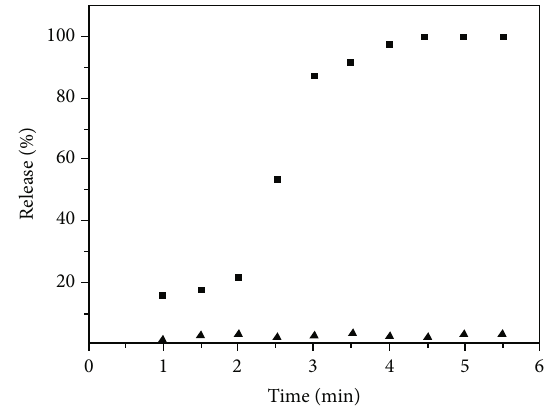
Figure 50: Release kinetics of β -carotene from polyamide microcapsules in water at 20 ° C in the absence (triangular symbols) and in the presence (square symbols) of continuous irradiation with UV light [143].